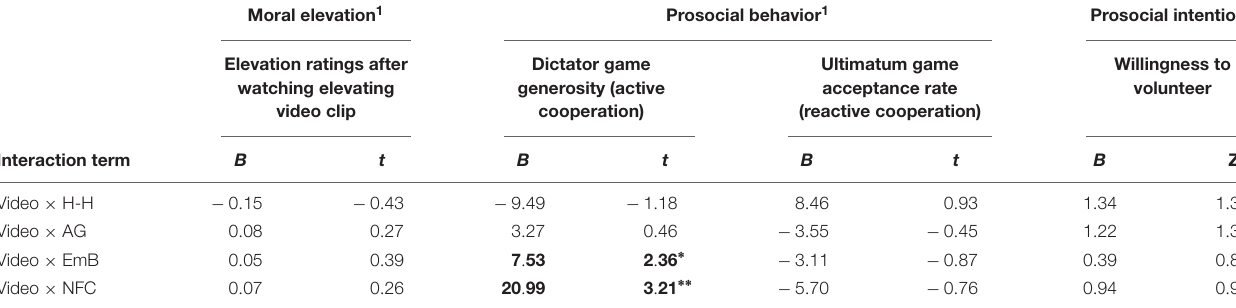
TABLE 2 | Moderation analyses.